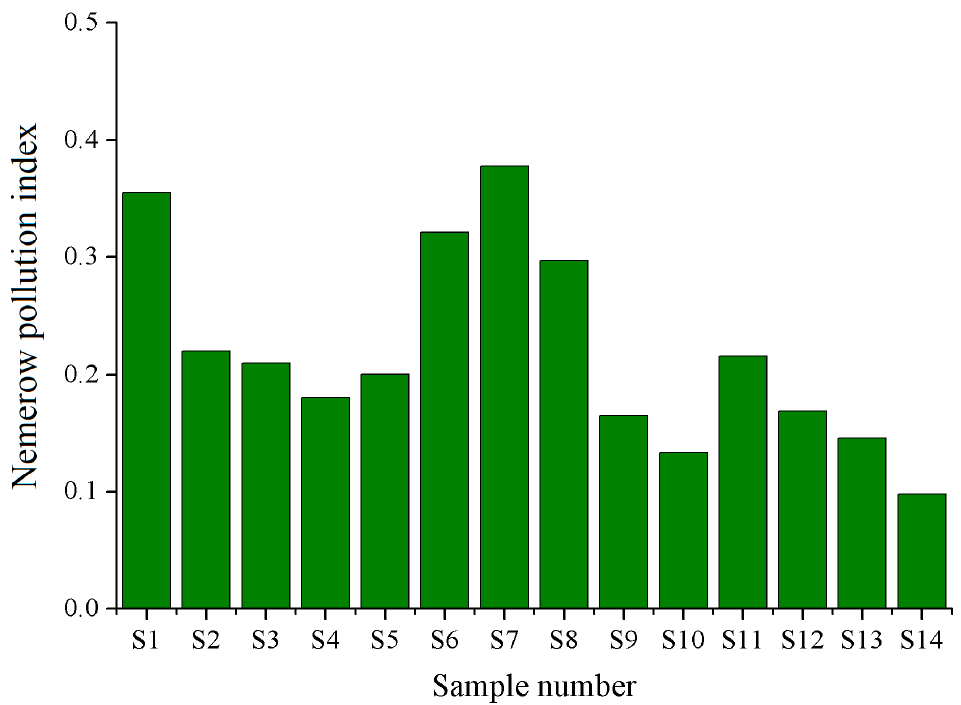
Figure 2. Single pollution indexes of heavy metals in winter jujube fruits.